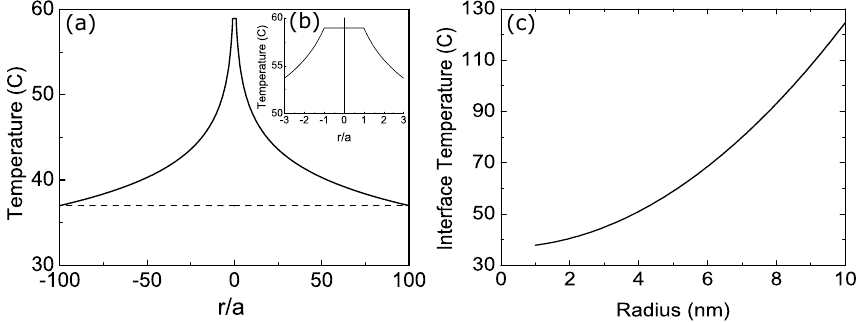
Figure 3. ( a ) The temperature profile of CNT and its surrounding as a function of radial distance relative to the radius of CNT during laser heating process. ( b ) The temperature profile in the regions of 0 < r < a . ( c ) The interface temperature during laser heating as a function of CNT radius. The physical parameters can be seen in Table 1.